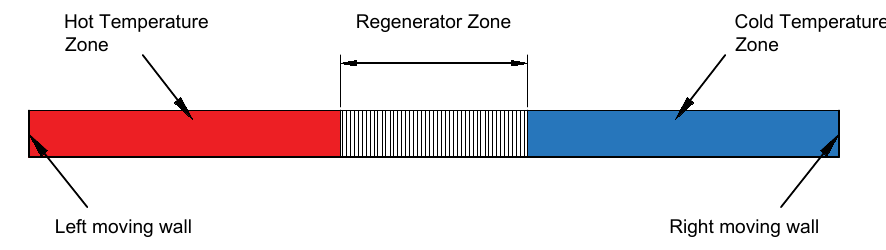
Figure 5. Two-dimensional regenerator model.